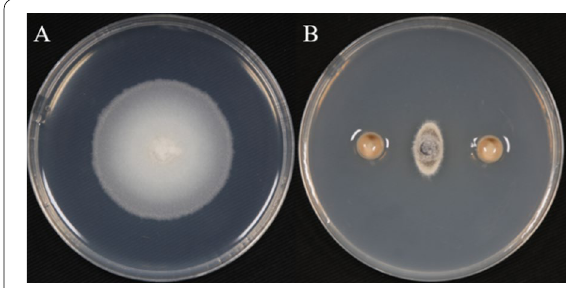
Fig. 1 Inhibitory effect of nonvolatile metabolite of EBS03 on V. dahliae . A control; B treated with EBS03